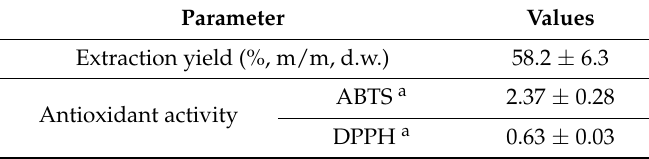
Table 1. Extraction yield and antioxidant activities of S. nigra L. polar berry extract. Parameter Values Extraction yield (%, m/m, d.w.)